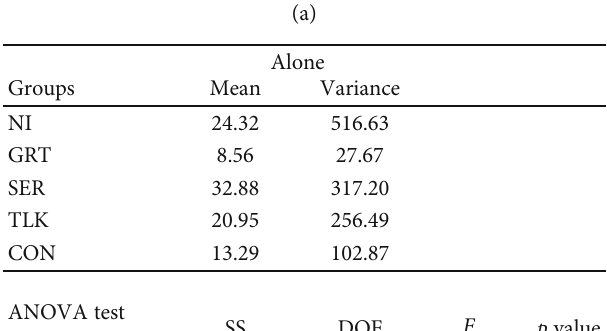
Figure 8: A stacked graph drawn for the comparison of conversational preferences with the two conditions: when the user is alone and when surrounded by few people. The type of interaction is plotted against the frequency of each type of interaction preferred in above two the